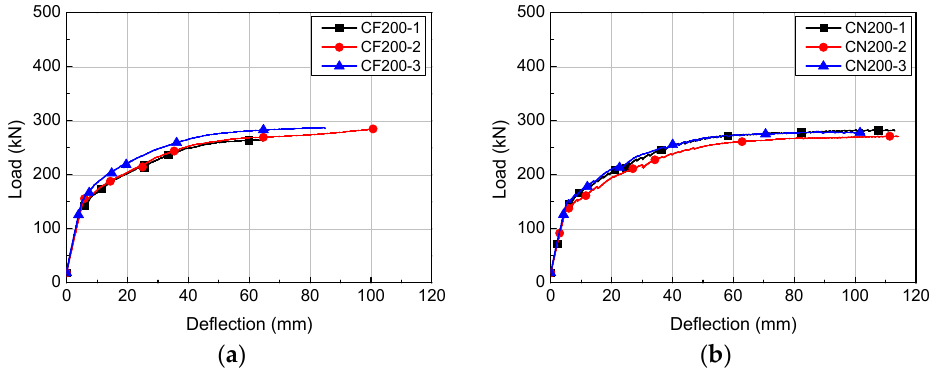
Figure 6. Load-deflection relationships of H200 series: ( a ) CF200; ( b ) CN200.